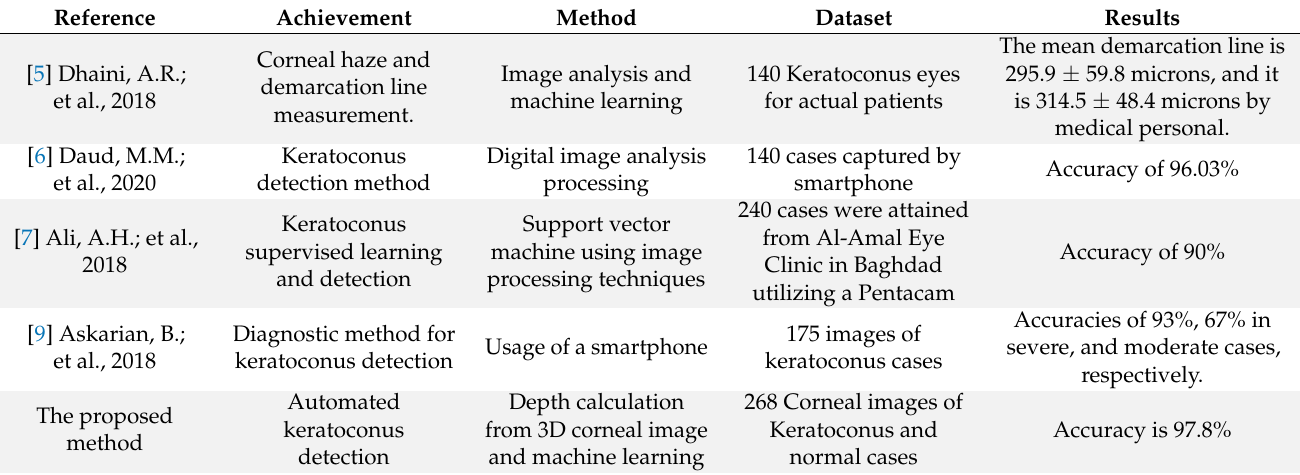
Table 1. Automated keratoconus detection